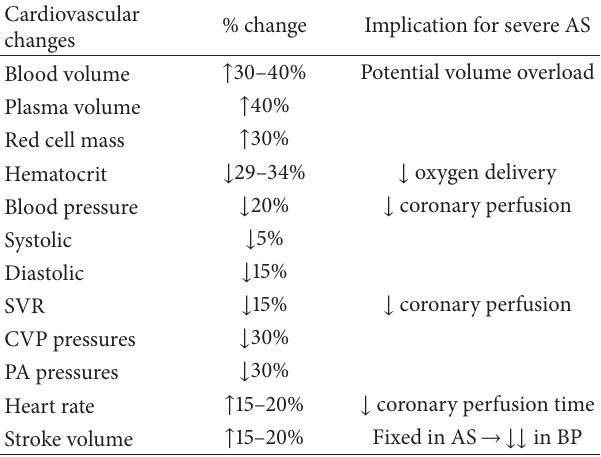
Table 1: Hemodynamic changes associated with pregnancy.